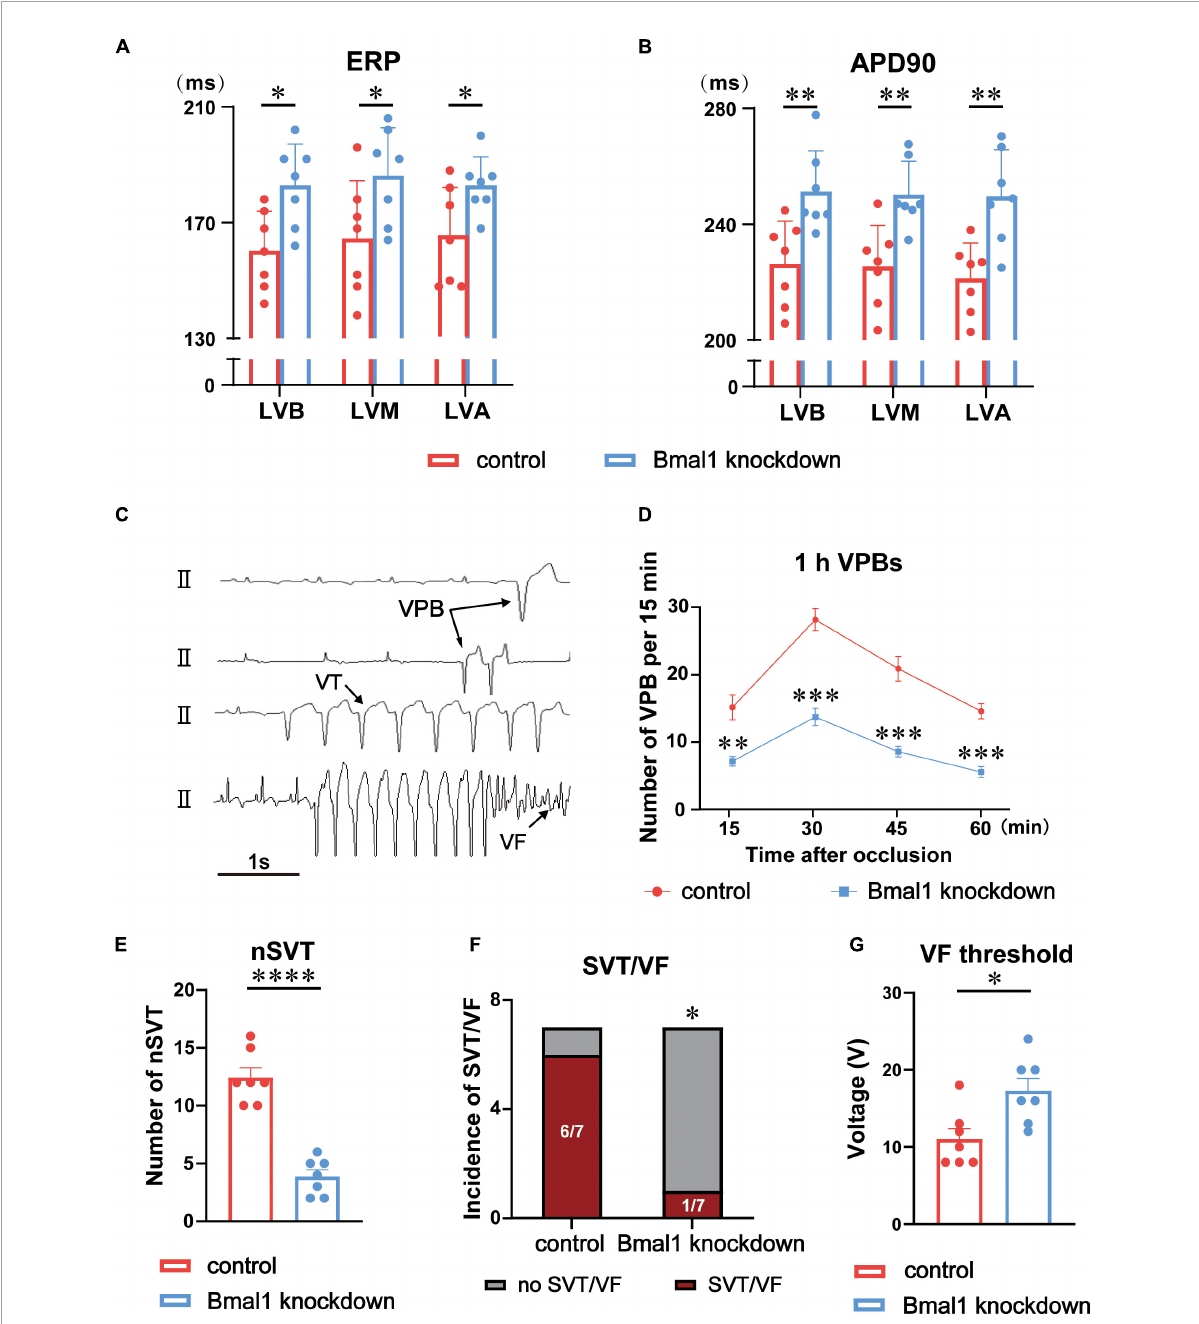
FIGURE2 Effects of Bmal1 knockdown in the LSG on ERP and VAs after ischemia. (A) Left ventricular ERP and (B) APD90 in the two groups at three sites: LVB, LVM, and LVA. (C) Patterns of VAs. Quantitative analysis of the occurrence of ischemia-induced VAs including (D) 1 h VPBs, (E) nSVT, and (F) the incidence of SVT and VF. (G) VF threshold in the two groups. n = 7 for each group. ∗ p < 0.05. ∗∗ p < 0.01. ∗∗∗ p < 0.001. ∗∗∗∗ p < 0.0001. LSG, left stellate ganglion; LVB, left ventricular base; LVA, left ventricular apex; LVM, mid left ventricle; ERP, effective refractory period; APD, action potential duration; VAs, ventricular arrhythmias; VPBs, ventricular premature beats; nSVT, non-sustained VT; SVT, sustained ventricular tachycardia; VF, ventricular fibrillation.